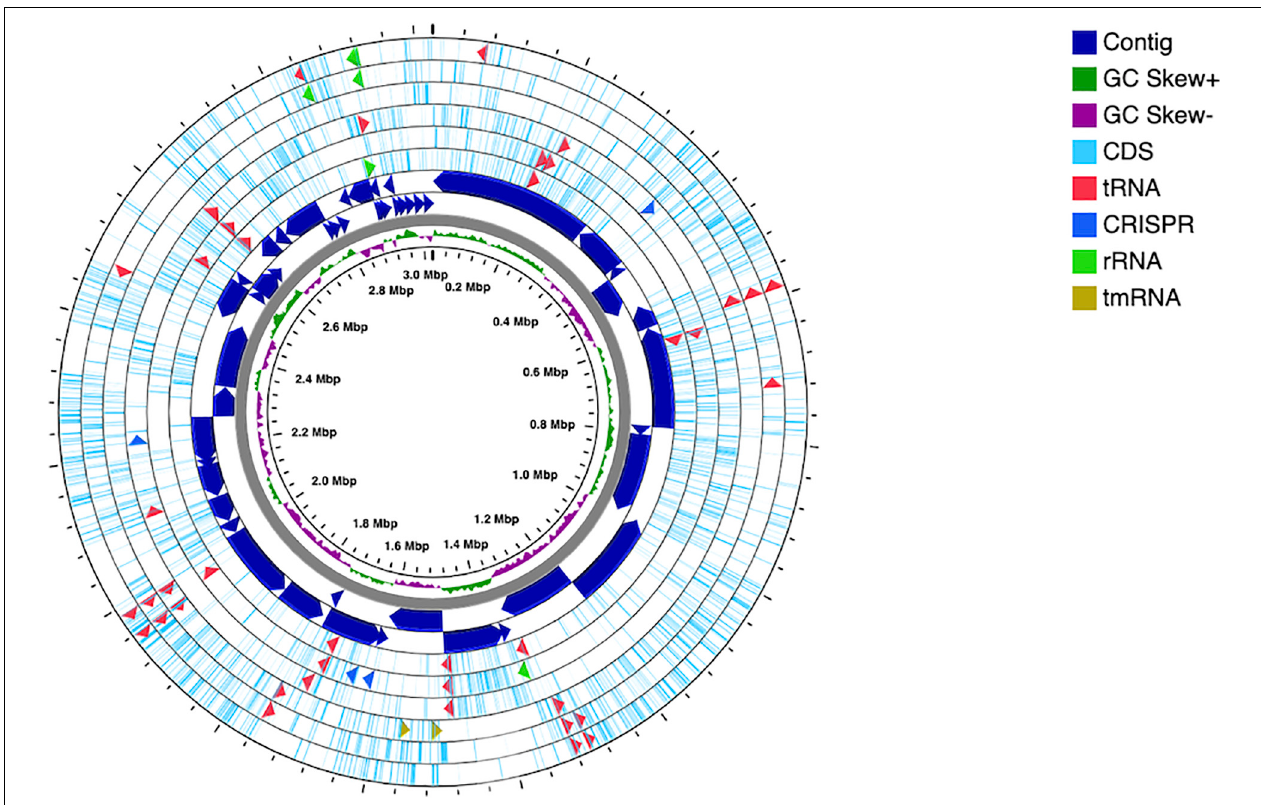
FIGURE 2 | Circular map of Alicyclobacillus mali FL18 genome performed using CGview Server. From the center to outside: genome size, with a ring showing the GC skews (positive values in green and the negatives in purple); the contigs, represented as dark blue arrows in a double ring to indicate the strands plus and minus; the CDSs are reported in light blue, together with tRNA (red), rRNA (green), tmRNA (dark red), and CRISPR